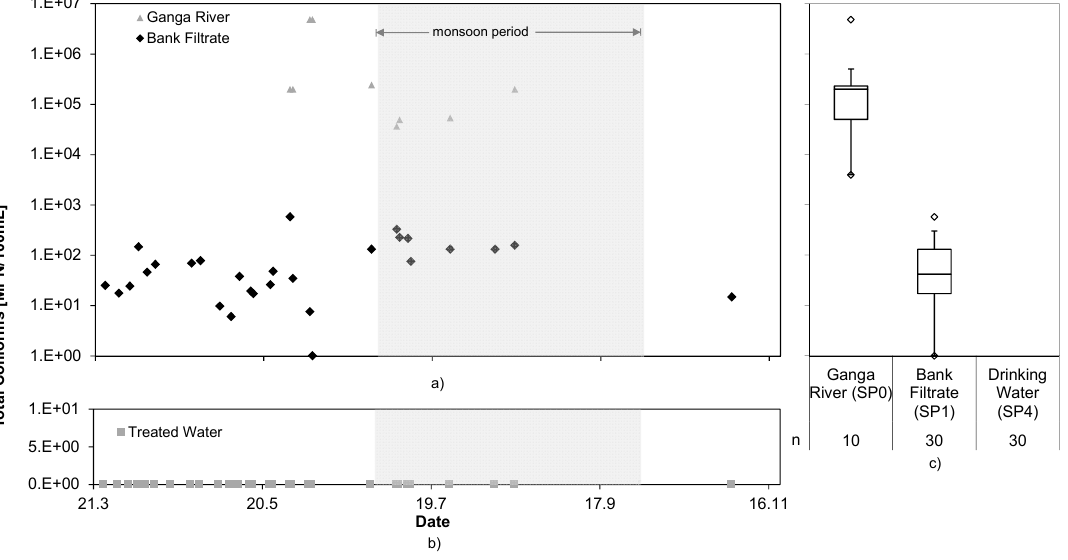
Figure 6. Total coliforms in the Ganga River water and bank filtrate ( a ) and drinking water ( b ), and statistical interpretation ( c ); trial period March–November.